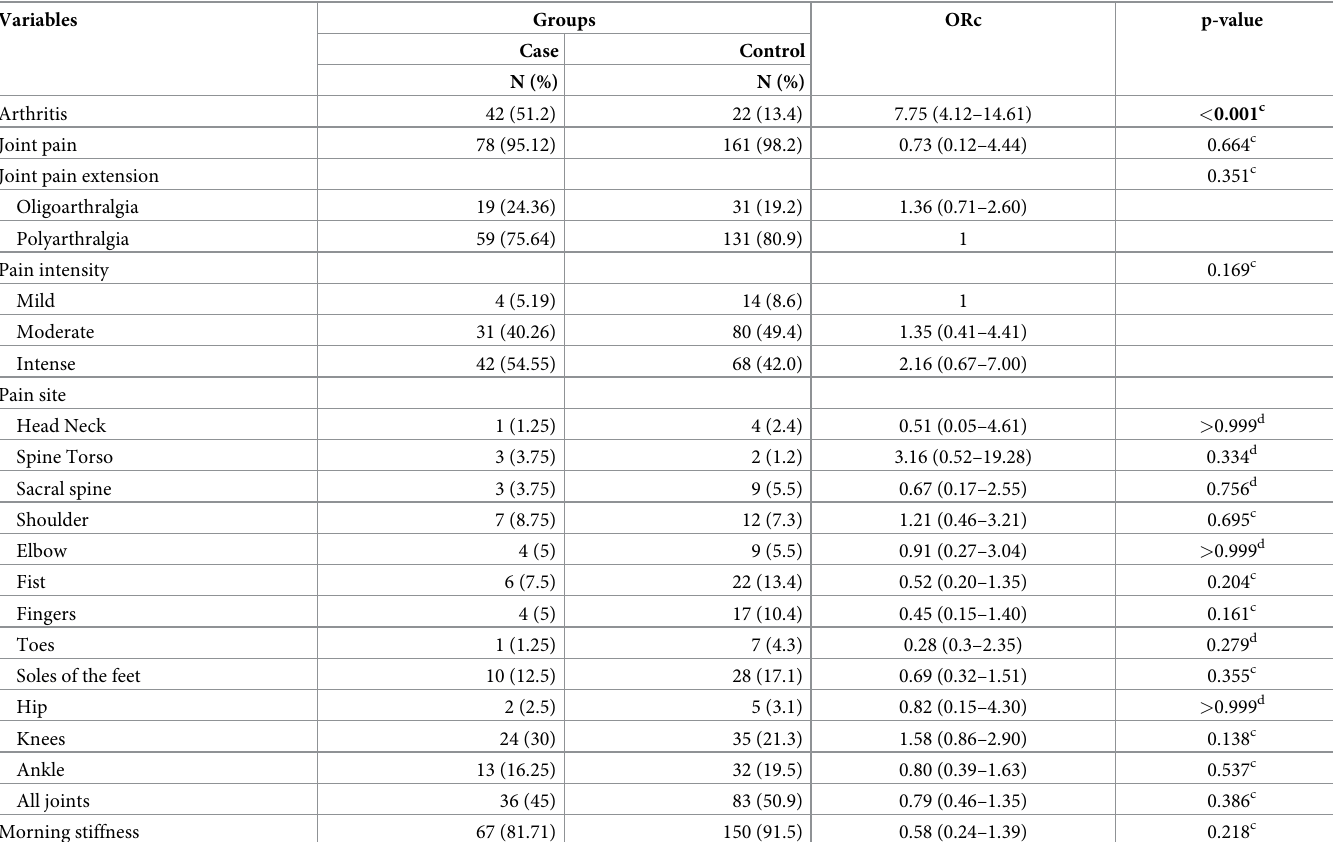
Table 3. Frequency of musculoskeletal signs and symptoms associated with likelihood of death from Chikungunya. Fortaleza (Brazil),